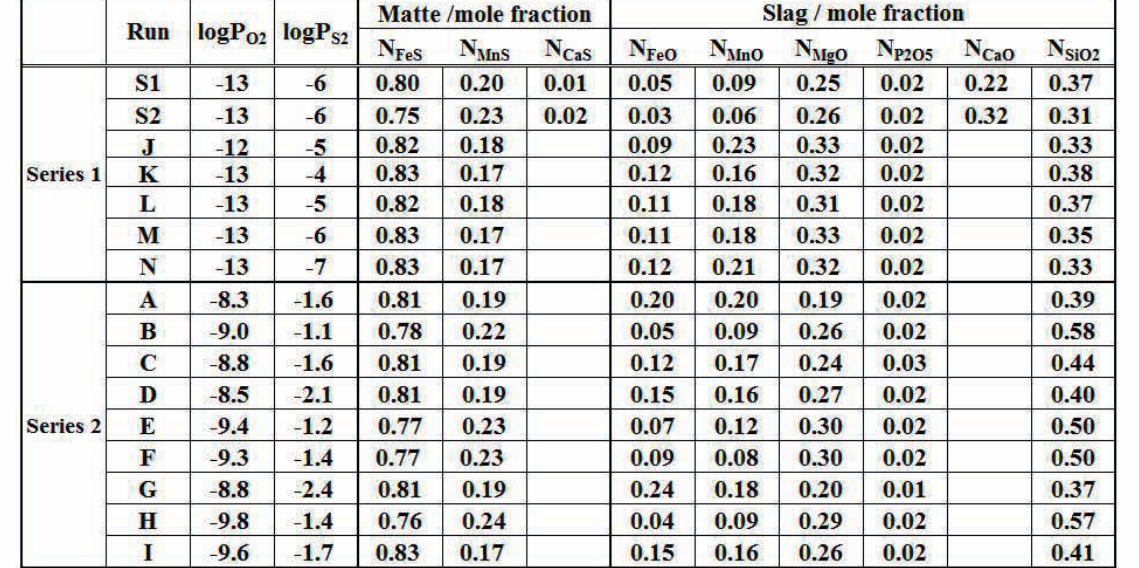
Table 6. Mole fractions of matte and slag for series 1 and 2.